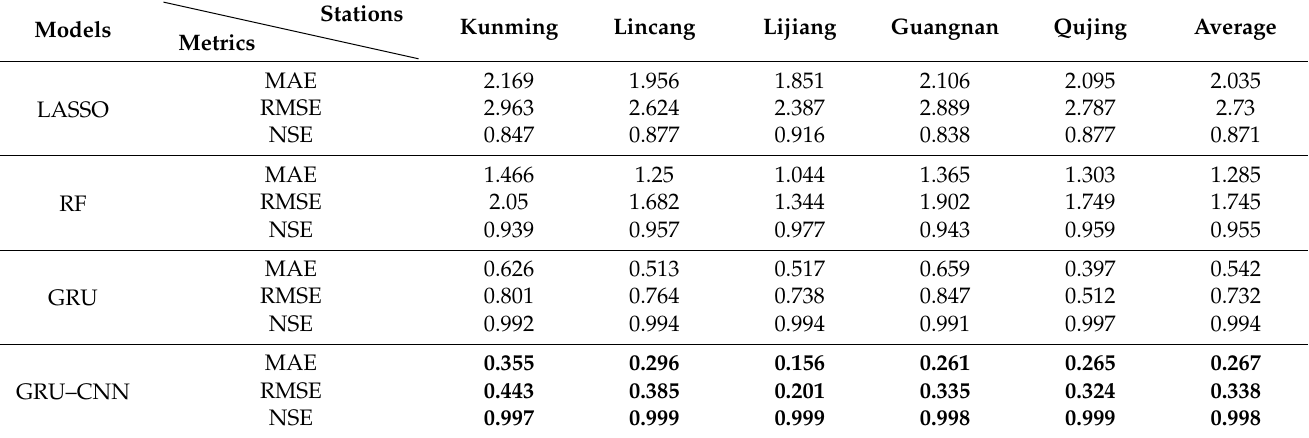
Table 6. Performance of MCI drought index prediction models computed in the 2nd month in the future.